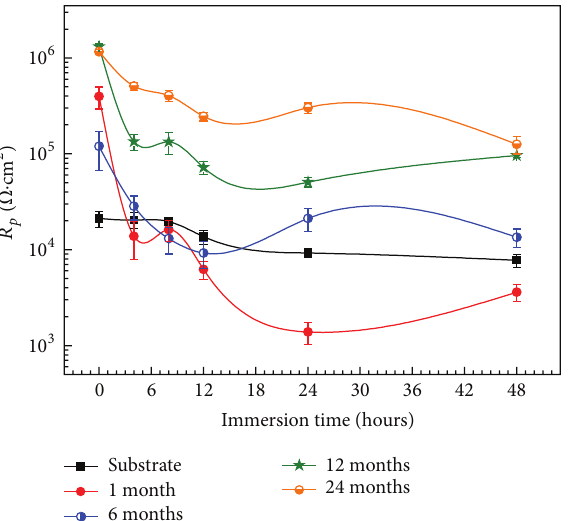
Figure 13: Calculated polarization resistance (𝑅 𝑝 ) of 2A12 alu- minum alloy after exposure for different